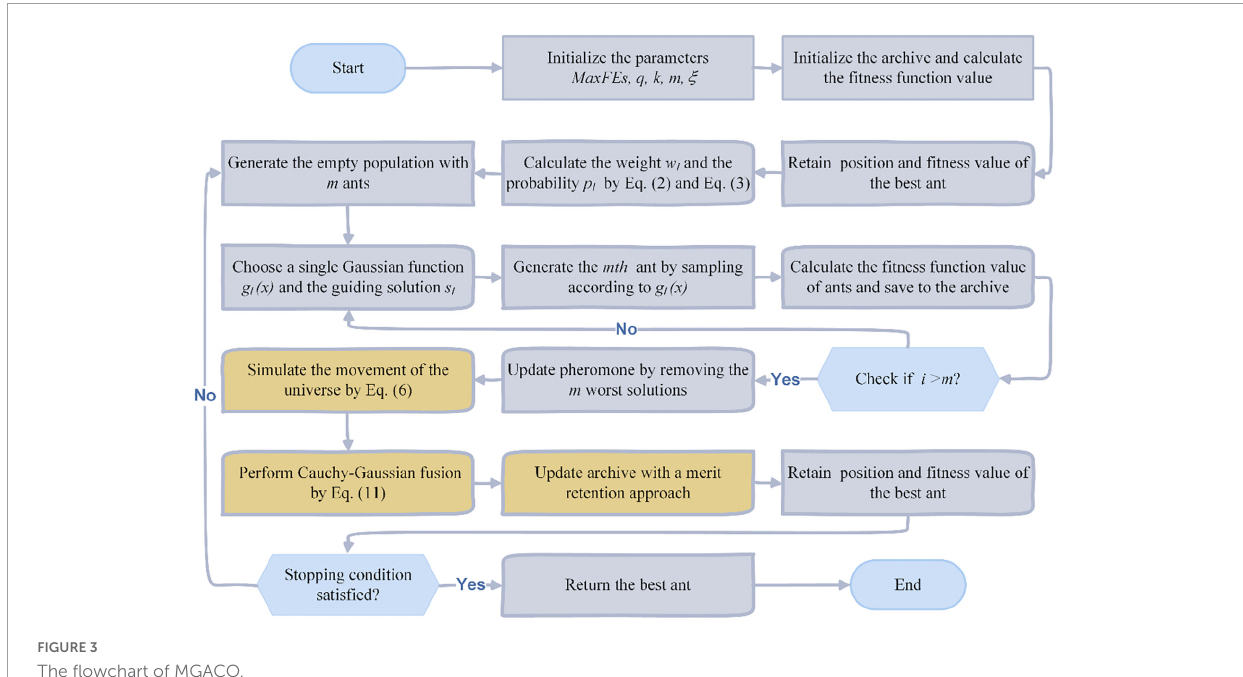
FIGURE3 The flowchart of MGACO.